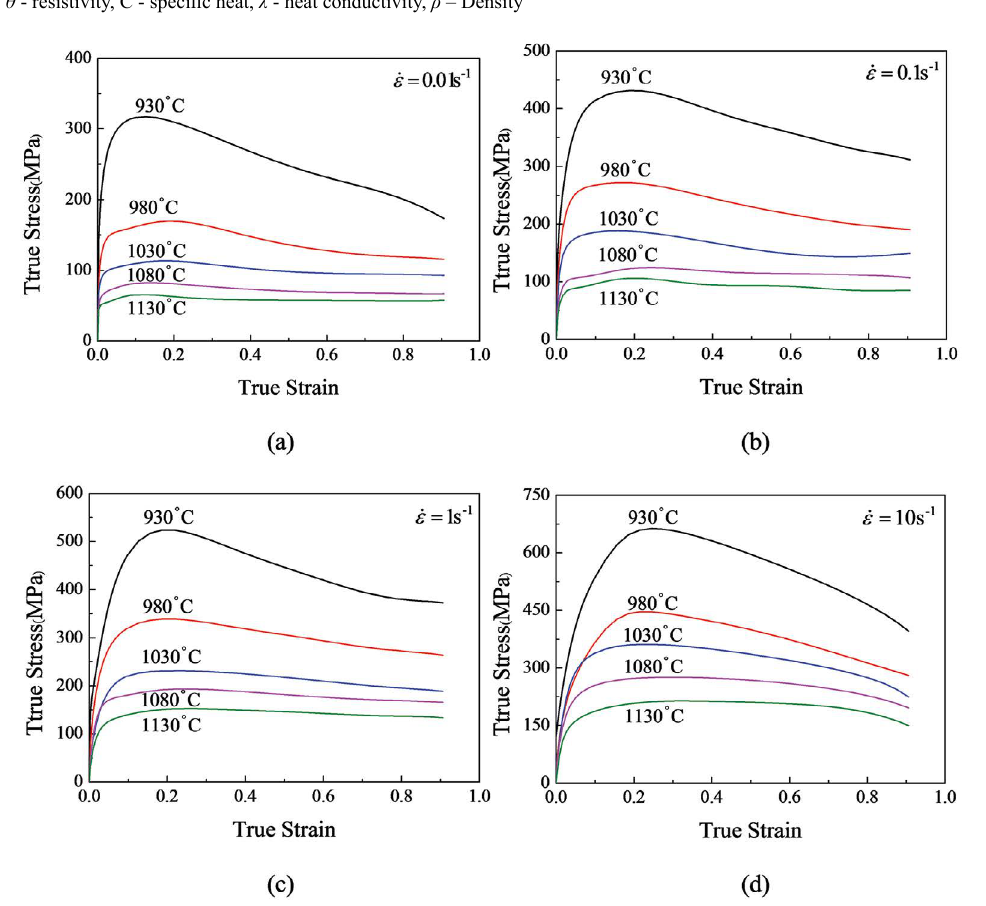
Figure 7: The true stress-strain curves of 3Cr20Ni10W2 alloy at different temperatures and strain rates (a) 0.01 s-1, 930~1130 0C; (b) 0.1 s-1, 930~1130 0C; (c) 1 s-1, 930~1130 0C; (d) 10 s-1, 930~1130 0C.